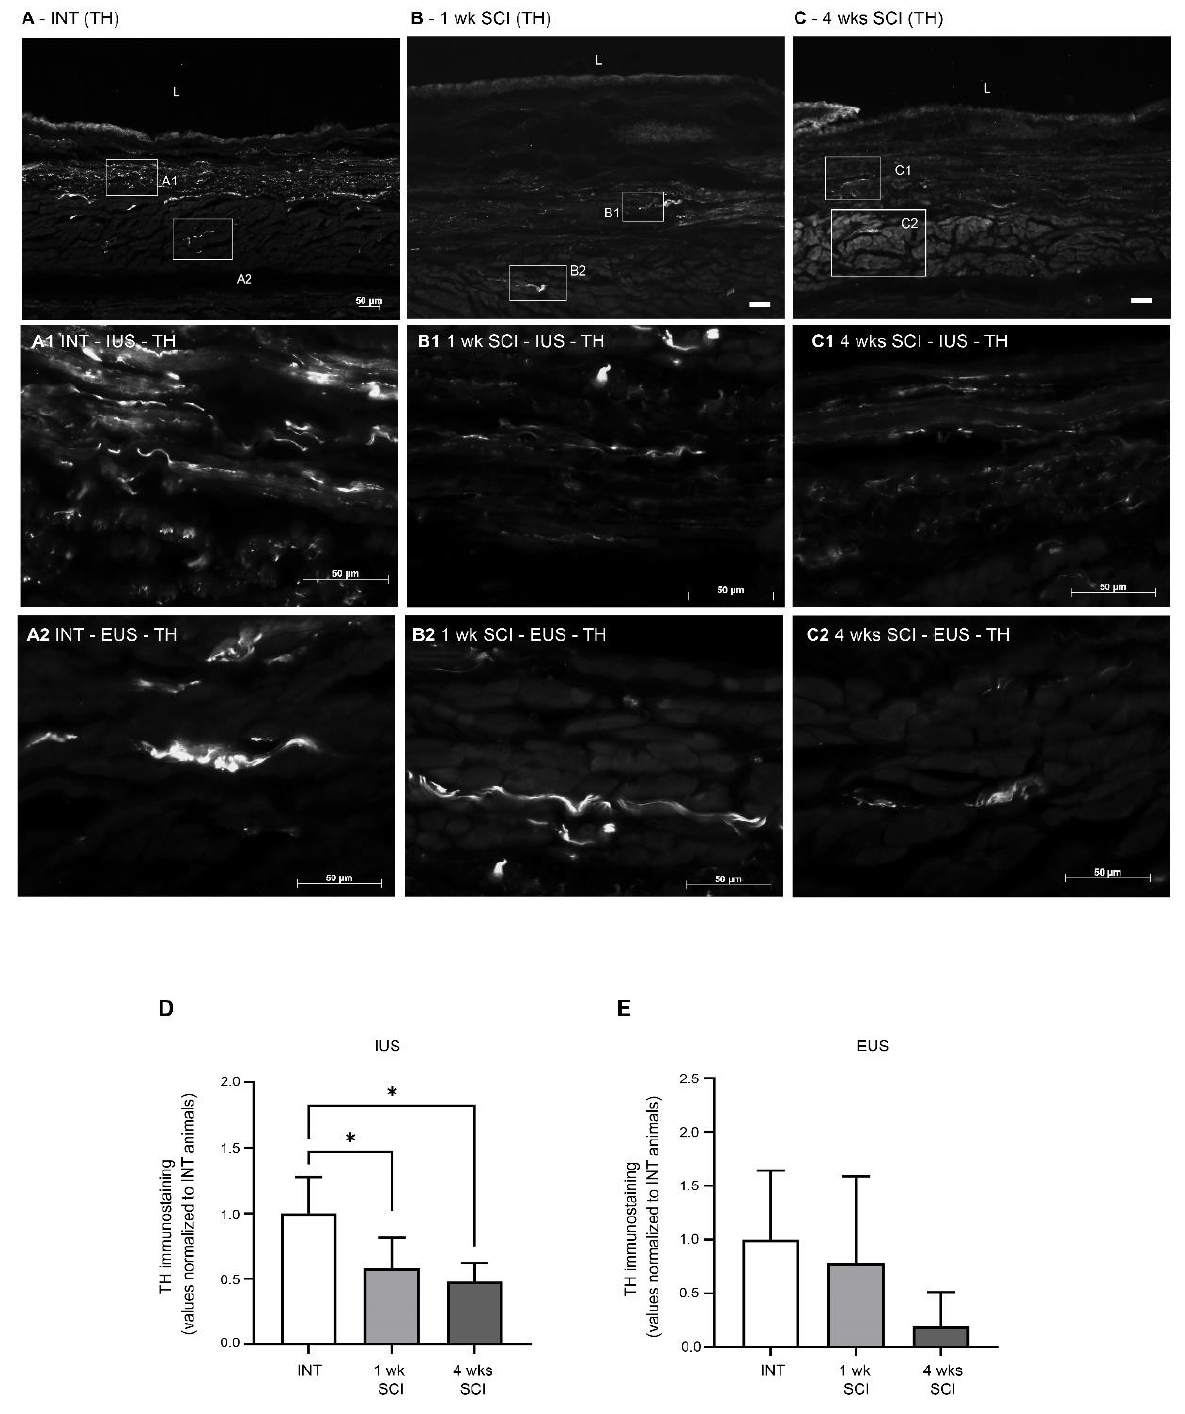
Figure 7. Expression of tyrosine hydroxylase (TH) in the urethral sphincter. Sympathetic innervation was analysed using TH immunohistochemistry, a noradrenergic marker for sympathetic fibres. Intact animals ( A ) presented TH-positive fibres predominantly in the internal and external urethral sphincter (IUS, ( A1 ); EUS, ( A2 ), respectively). No TH fibres were observed in the mucosa. Positive fibres were also present in sections from 1-week SCI animals ( B , B1 , B2 ), in which a prominent reduction was observed. This sympathetic denervation was also evident in sections from 4-weeks post-SCI animals ( C ), both in the IUS ( C1 ) and EUS ( C2 ). Scale bars equal 50 µ m. The quantification of labelling intensity by Image J in the IUS ( D ) and EUS ( E ) ( n = 4). One-way ANOVA followed by Tukey’s multiple comparison test (* p < 0.05 vs. INT).